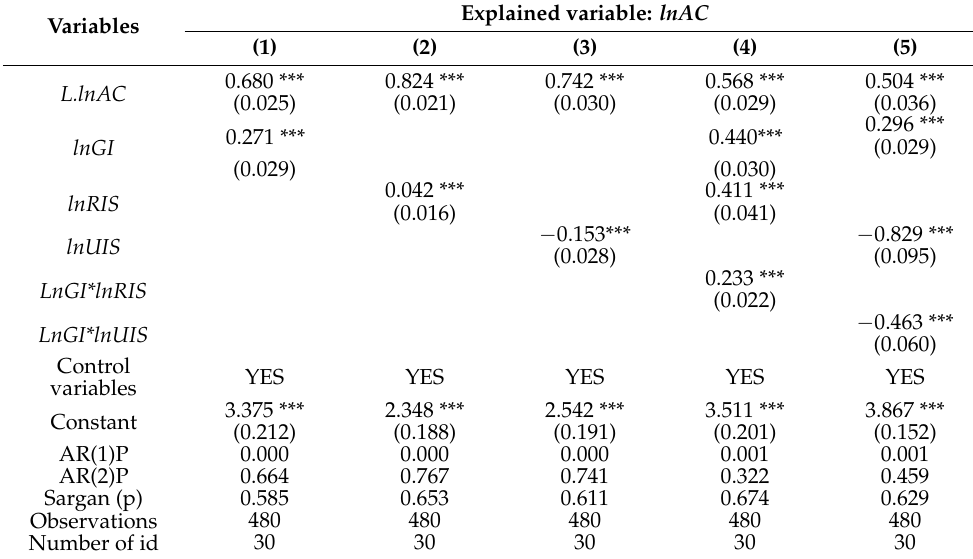
Table 4. Dynamic panel regression